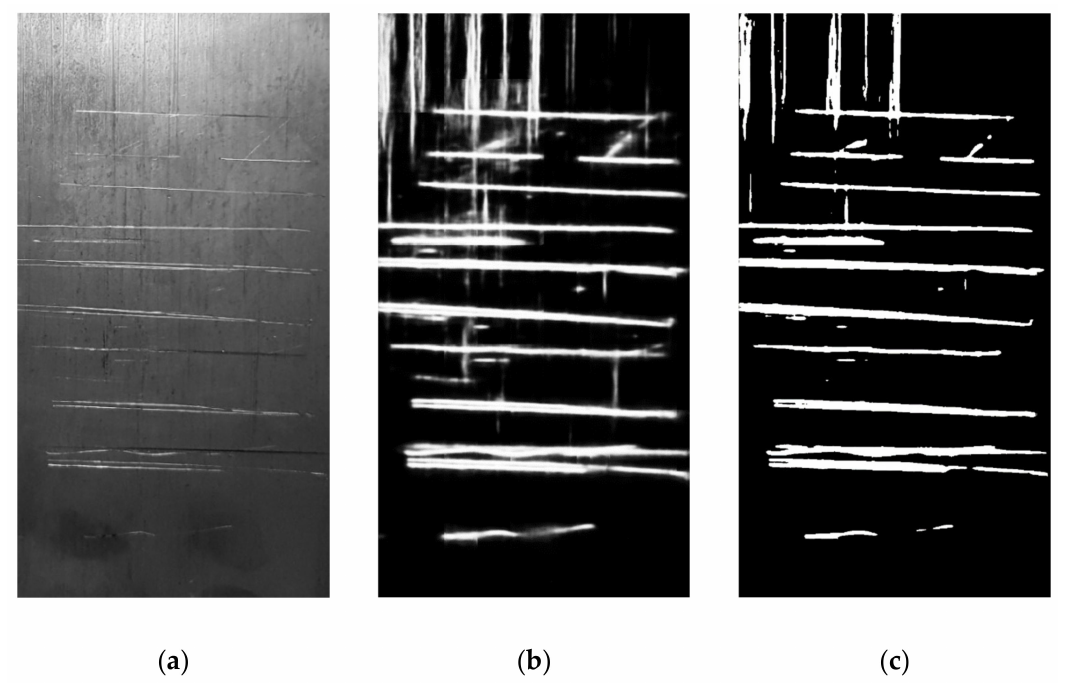
Figure 5. Initial ( a ), recognized and synthesized ( b ), and binary ( c ) surface image at 50 lx.